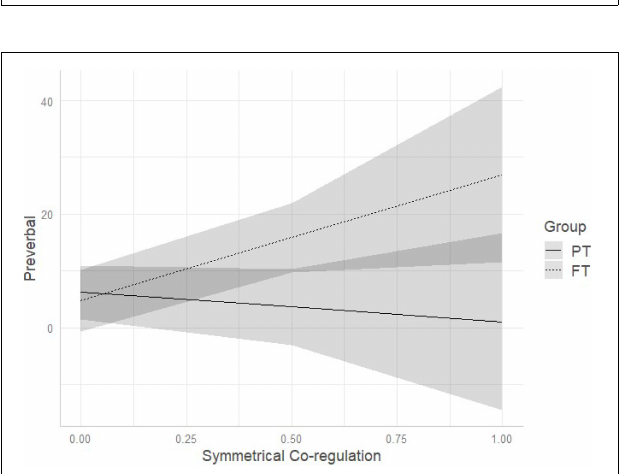
FIGURE 3 | Interaction among birth status and symmetrical co-regulation on IDS control pragmatic sentences. PT, preterm, FT, full-term.